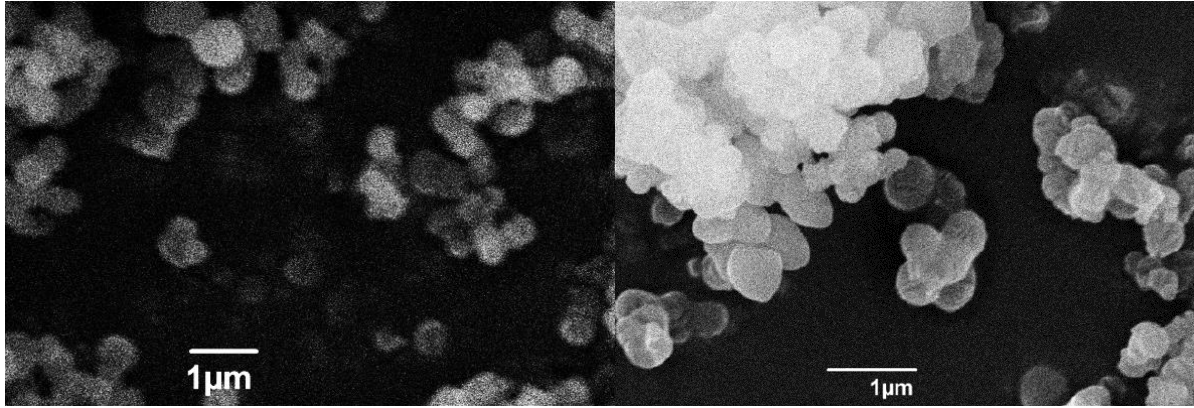
Figure 2. SEM image of the fresh PMO-Py ( left ) and recycled PMO-Py-IL after ten runs ( right ).